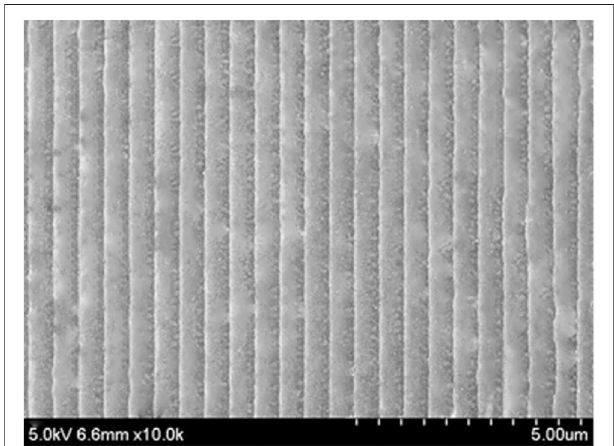
FIGURE 4 | SEM image of aluminum fi lm grating.